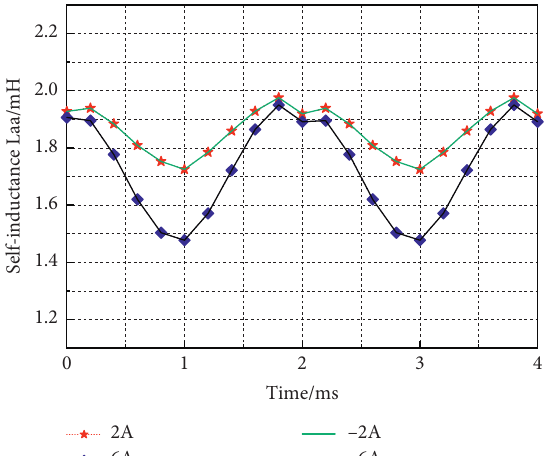
Figure 19: The self-inductance Laa with various field currents.